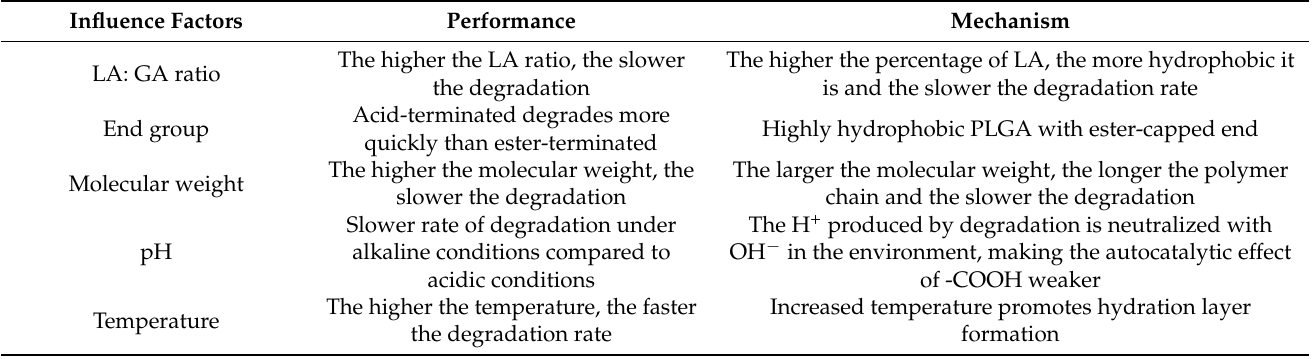
Table 1. The factors and mechanisms affecting the degradation of